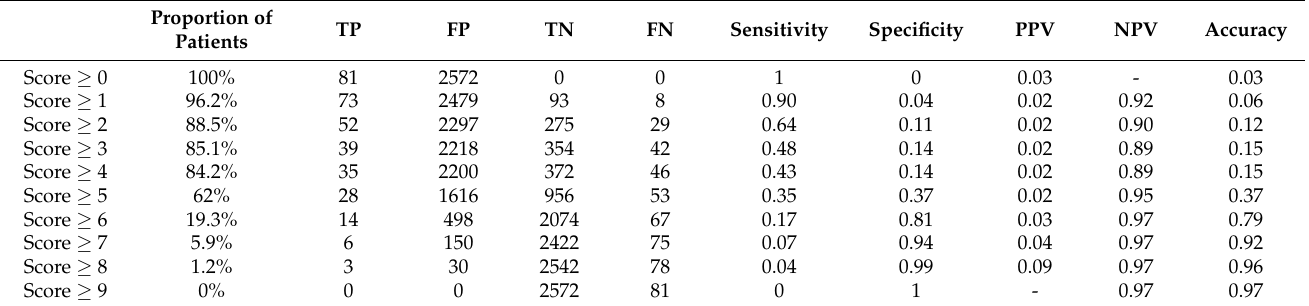
Table 3. Proportion of patients, sensitivity, specificity, positive predictive value, and negative pre- dictive values for different breakpoints according to the score predicting Pseudomonas aeruginosa bloodstream